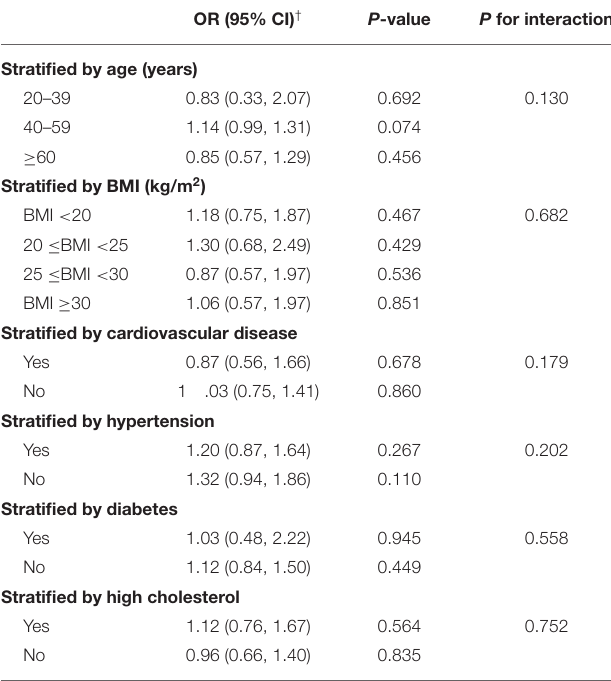
TABLE 3 | Subgroup analysis of the association between urinary 2,4-D and erectile dysfunction among U.S. men in the NHANES 2001–2004. OR (95% CI) † P -value P for